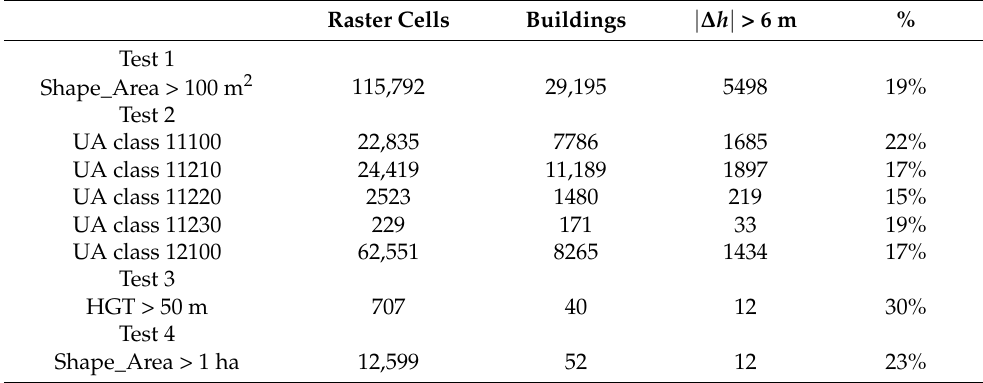
Table 3. Percentage of buildings with an error greater than 6 m between